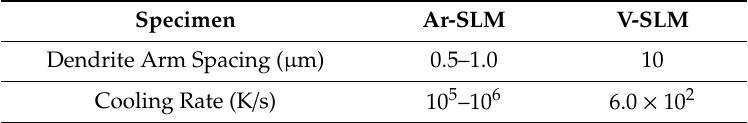
Table 8. Cooling rate and primary dendrite arm spacing of the as-built